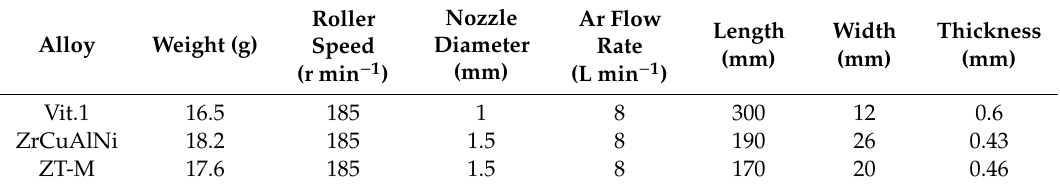
Figure 2. The metallic glass (MG) and metallic glass composite (MGC) strips produced via triple twin- roller casting technique, ( a ) Vit.1 MG with an inset of the measurement of its thickness, ( b ) ZrCuAlNi MG, and ( c ) ZT-M MGC strips. ( d ) The X-ray diffraction (XRD) spectra of the strips. Table 1. The used parameters for making the MG/MGC strips and the dimensions of the prepared MG/MGC strips.